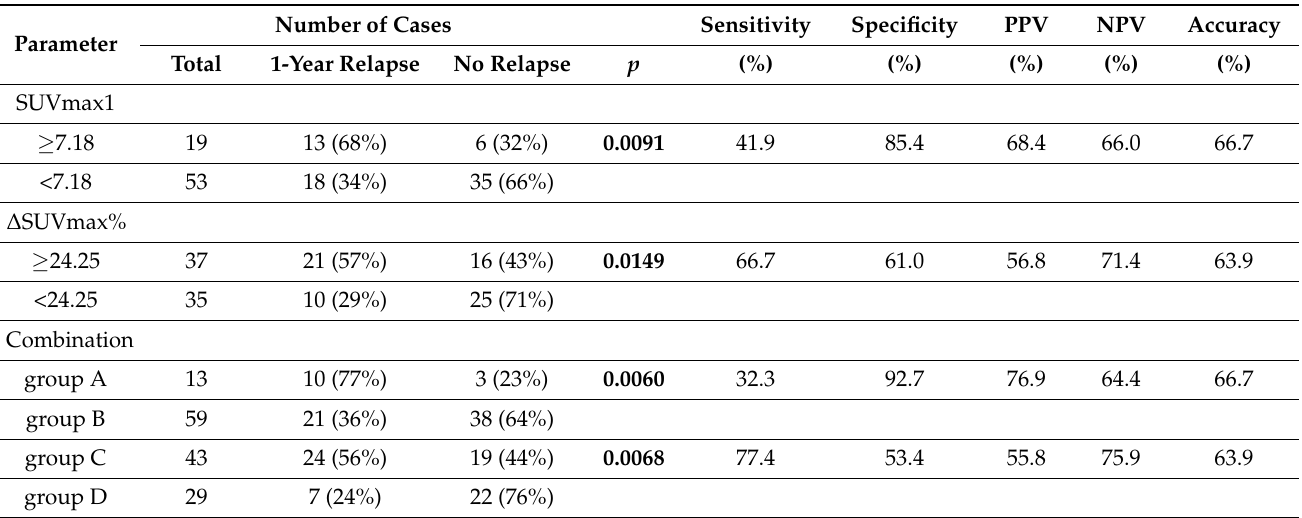
Table 2. Accuracy of SUVmax1, ∆ SUVmax%, and their combination for the prediction of relapse within 1 year of